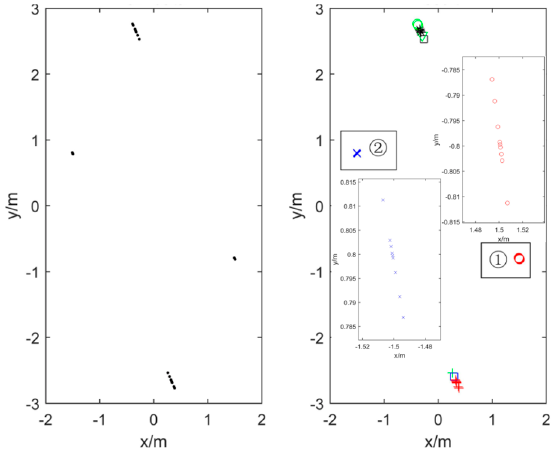
Figure 8. Using DBSCAN to solve the clustering e ff ect of translation matrix.